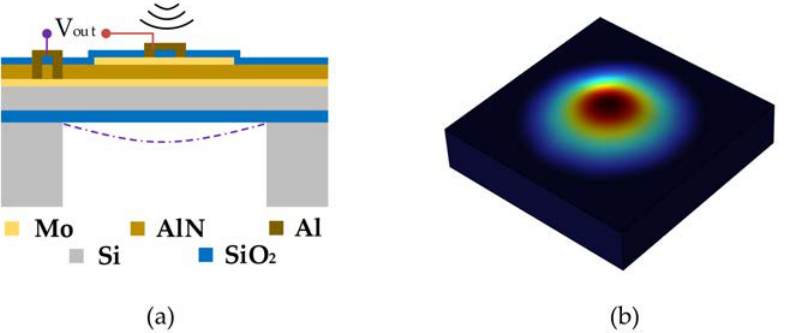
Figure 1. The PMUT structure: ( a ) cross-sectional view, ( b ) simulated mode shape of a sensing Figure 1. Th e PMUT structure: ( a ) cross - sectional view, ( b ) simulated mode shape of a sensing dia- diaphragm in the PMUT. phragm in the PMUT. Table 1. Geometric parameters of the PMUT.